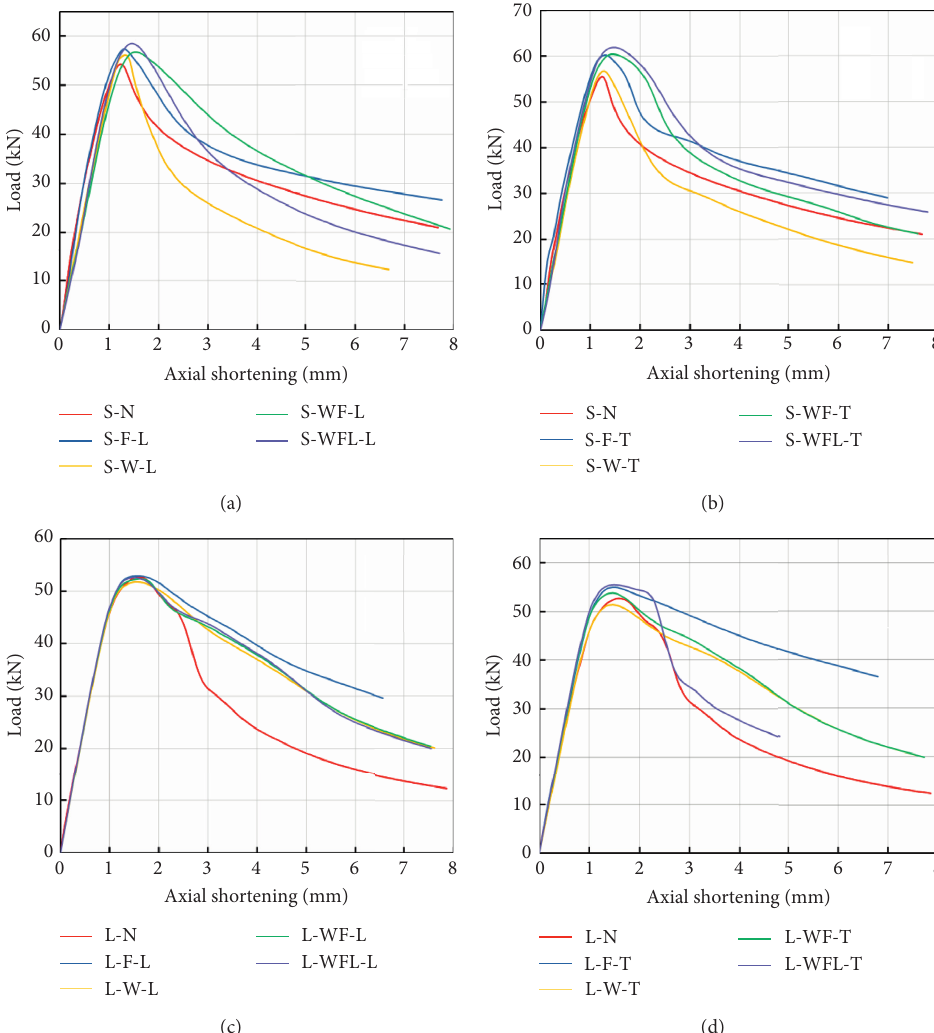
Figure 9: Curves for the (a) short column-fiber orientation 0 ° , (b) short column-fiber orientation 90 ° . (c) long column-fiber orientation 0 ° , and (d) long column-fiber orientation 90 °